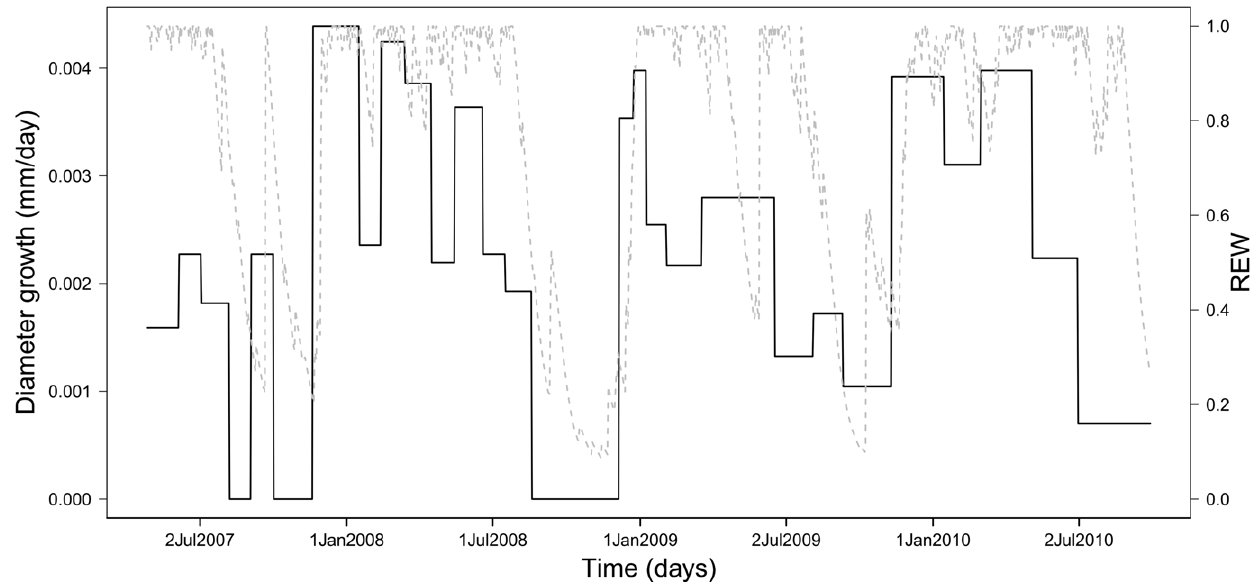
Figure 4. Averaged diameter growth of 205 trees from 54 neotropical species during 4 consecutive years plotted against the evolution of water availability ( REW , dashed line). Note that the highest increments occur in the first weeks of the wet season, regardless of the intensity of these early rainfall events.